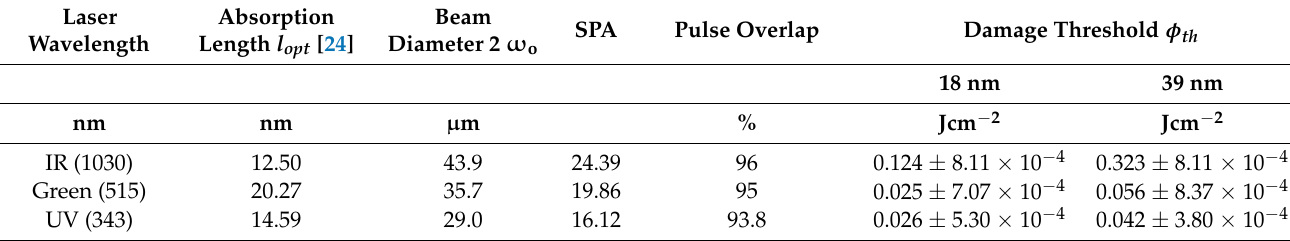
Table 1. Experimentally calculated parameters for 18-nm and 39-nm Au films on quartz substrates for a 500-fs laser operating at 100 kHz repetition rate.